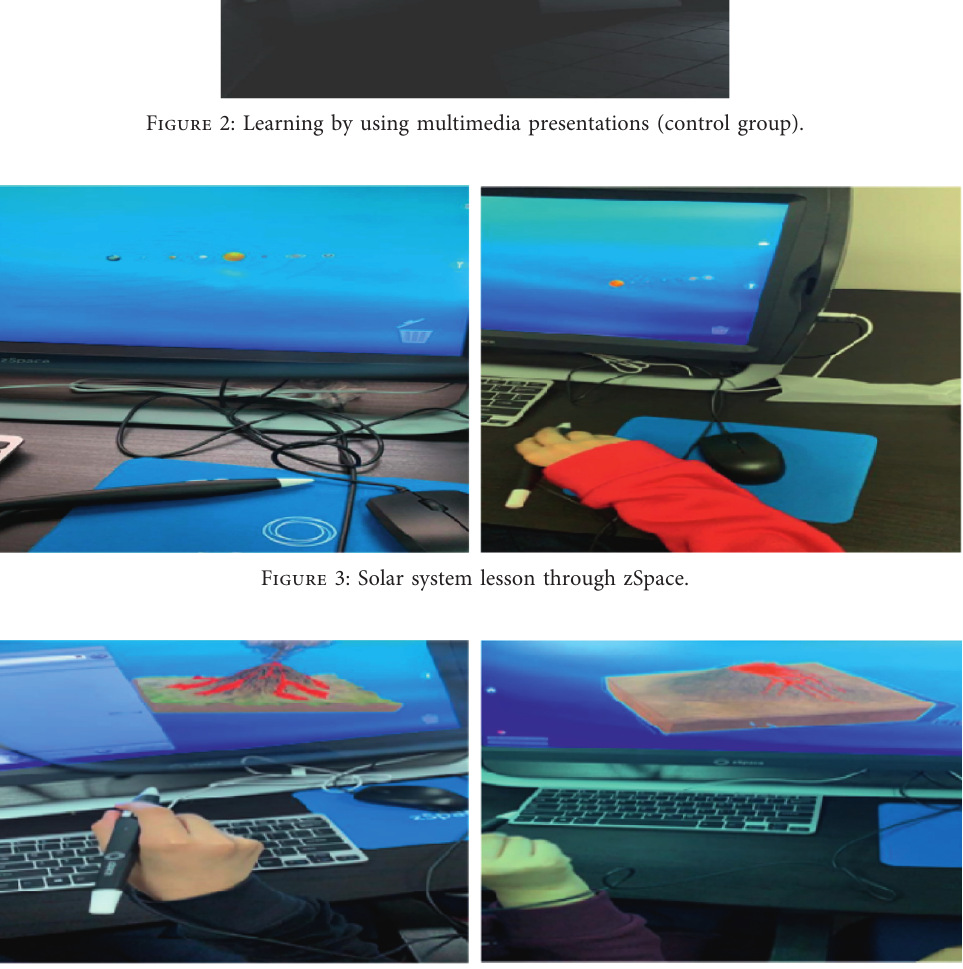
Figure 4: Volcanoes lesson through